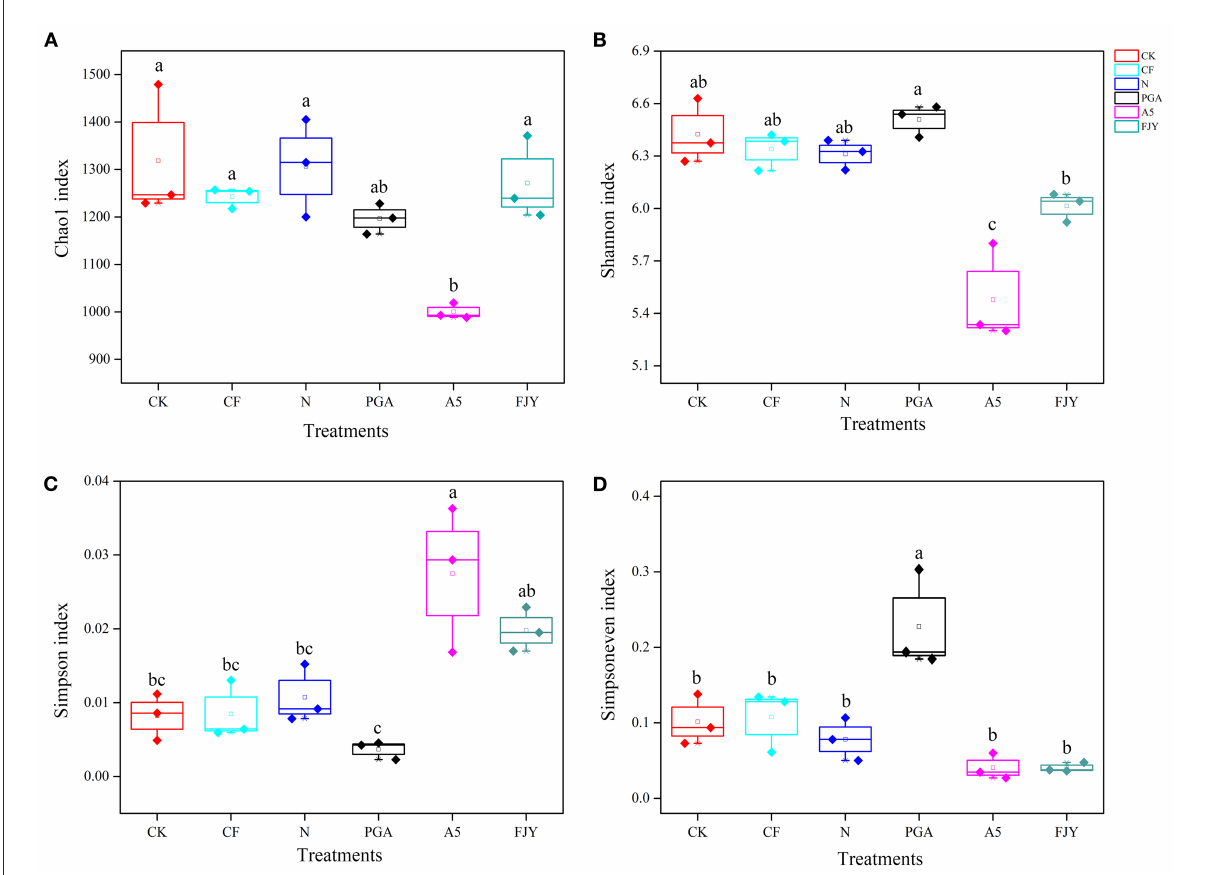
FIGURE2 Comparison of bacterial community ? diversity Chao1 index (A) , Shannon index (B) , Simpson index (C) , and Simpsoneven index (D) , in Chinese cabbage rhizosphere